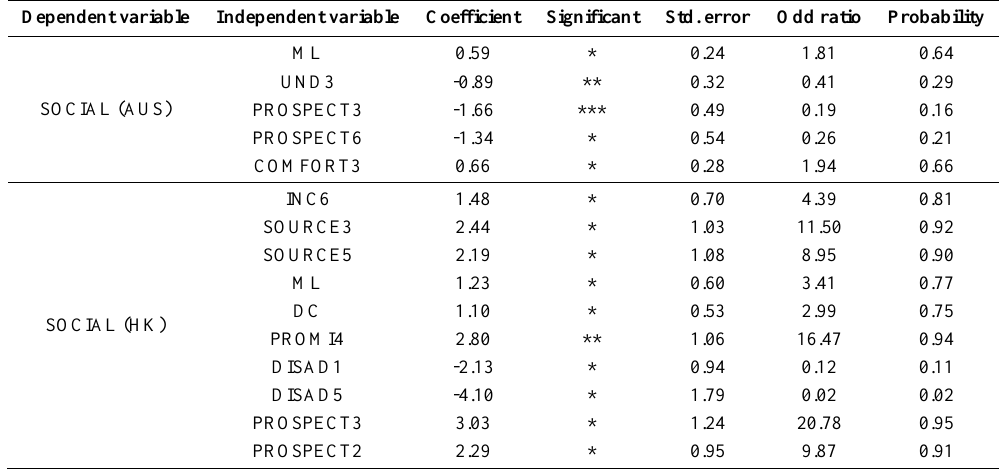
Table B- 9. Lack of clarity on if/how AI will be used for the common/social good of all community members Dependent variable